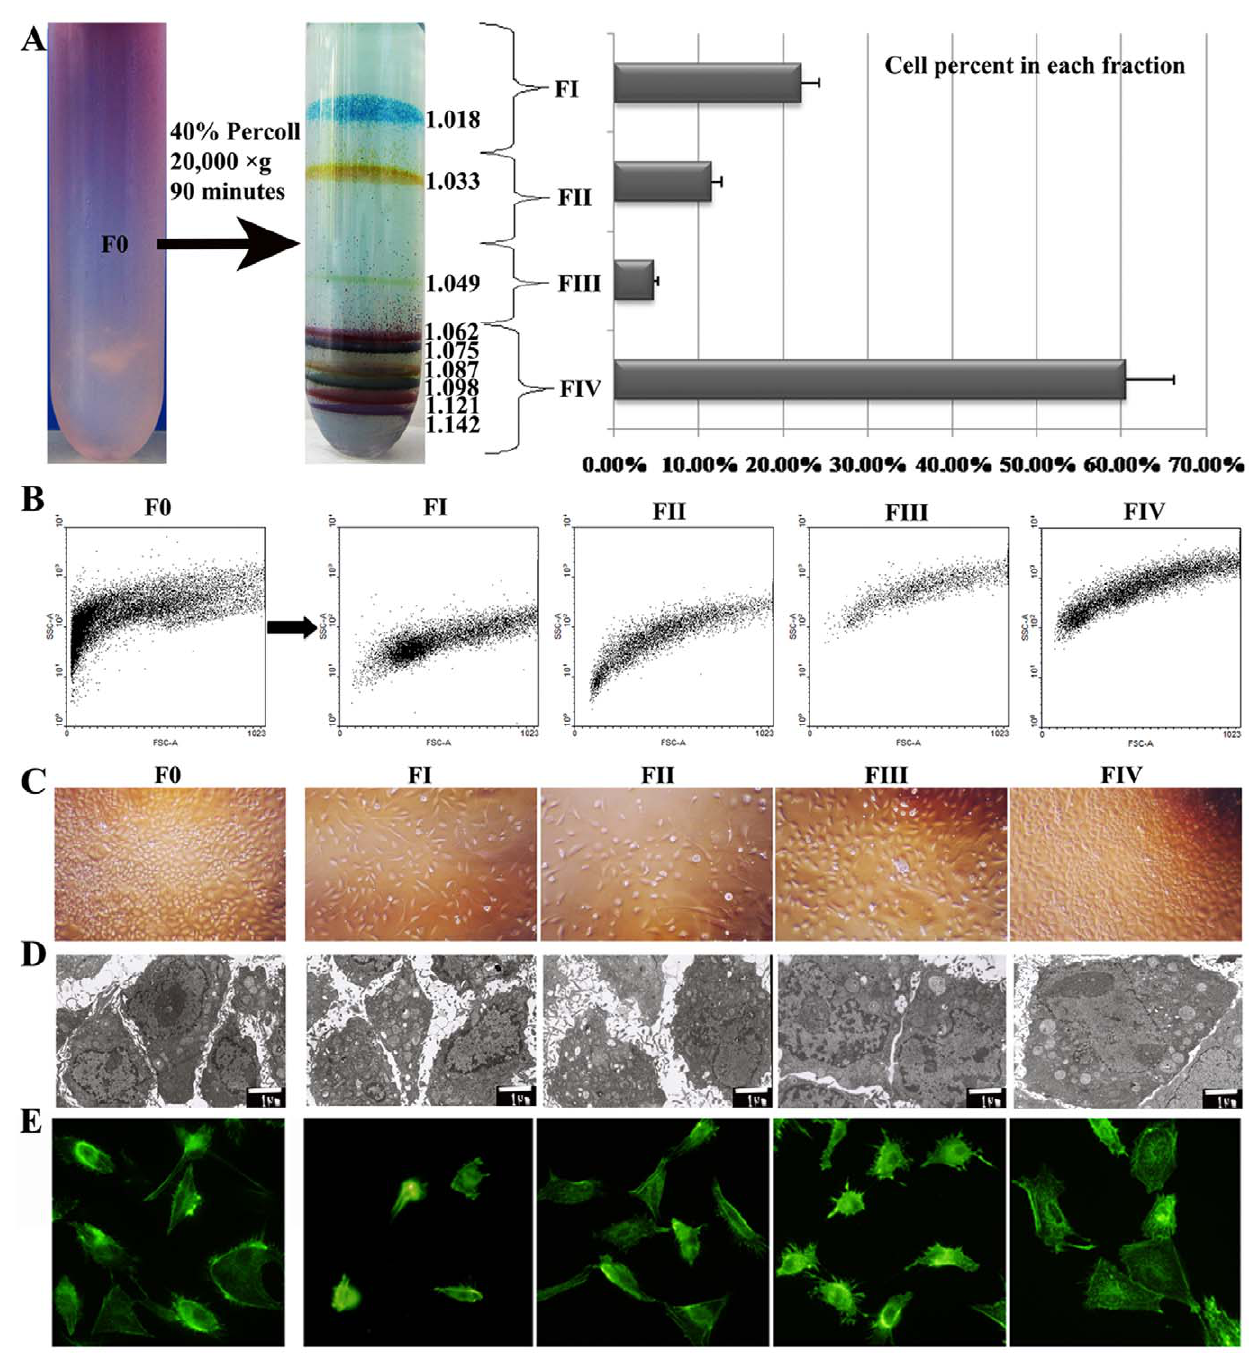
Figure 2. Separation of HTCs and morphological comparison. (A) Schematic illustration of the continuous Percoll gradient used for fractionation and the percentages of cells segregated in each fraction. (B) Dot-plot histograms resulting from FACS analysis showing the densities of cells in each fraction. (C) Light microscopy of cells from each fraction under phase. (D) TEM images and diameters of cells from each fraction. (E) Images of cell stained by phalloidin reflect the different morphologies of cell surfaces. Original magnifications: 100 6 (C), 6000 6 (D), 400 6 (E). doi:10.1371/journal.pone.0035720.g002 cells in FI were determined to be CK-19 positive (6.1% 6 0.54%), and almost no cells in F0, FII, FIII and FIV expressed CK-19 (Figure 3B, D).